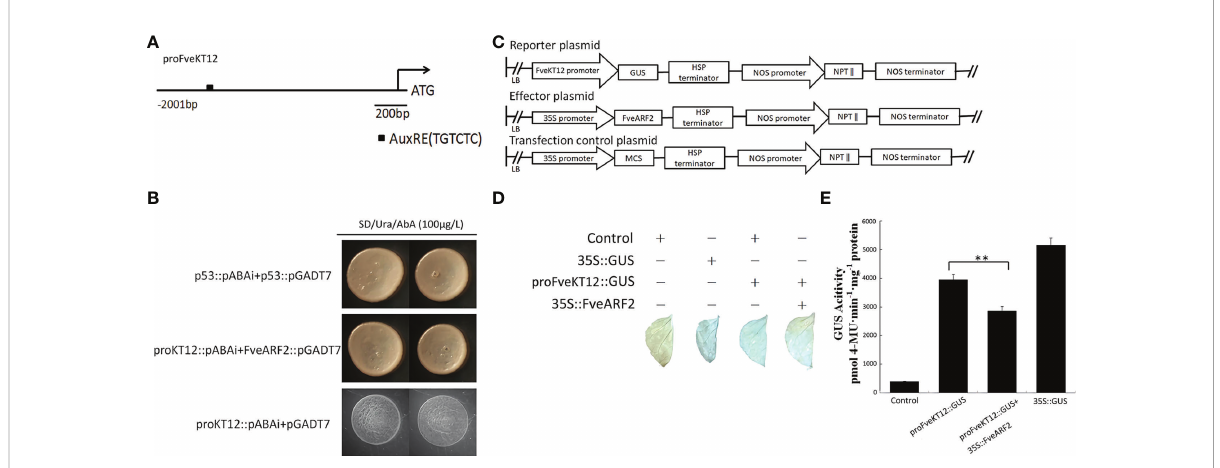
FIGURE 10 FveARF2 can bind to the FveKT12 promoter and negatively regulate its expression. (A) Structural diagram of the FveKT2 promoter. The block represents the AuxRE element (TGTCTC). (B) FveARF2 can bind to FveKT12 promoter in vitro . (C) Structural diagram of the reporter, effector, and control plasmids. (D, E) In vivo GUS activity analysis showing that FveARF2 negatively regulates FveKT12 expression. Values are the mean ± SD from three independent experiments with three biological replicates. ‘ ** ’ Indicates very signi fi cant differences (P < 0.01, Duncan ’ s multiple range